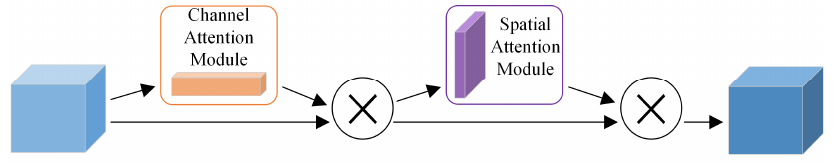
Figure 5. The structure of CBAM.